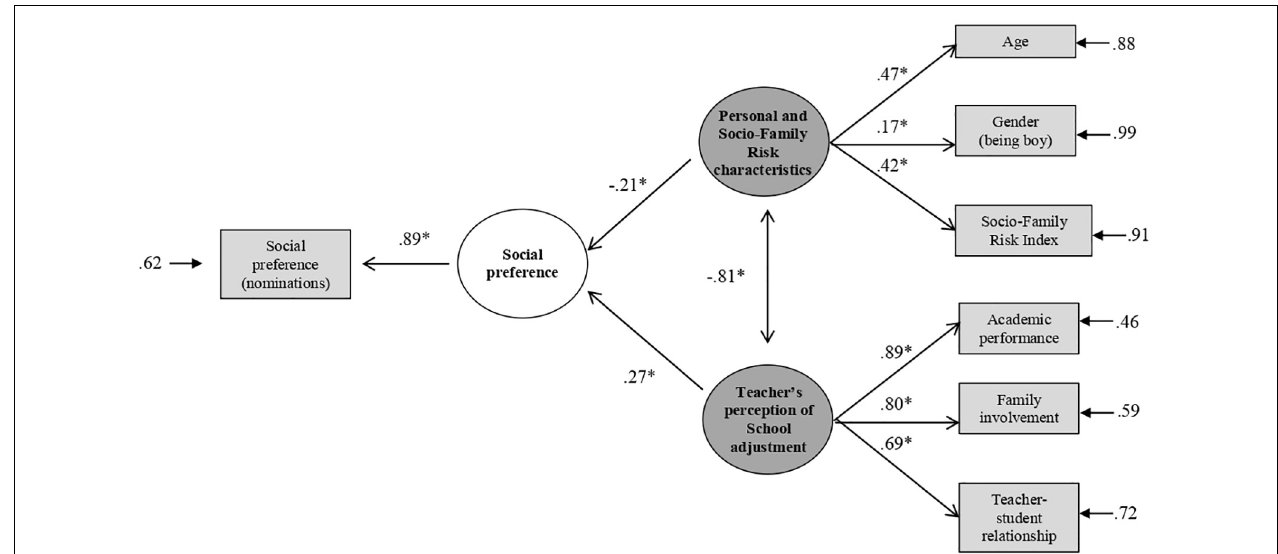
FIGURE 2 | Model of structural equations social preference. * p <